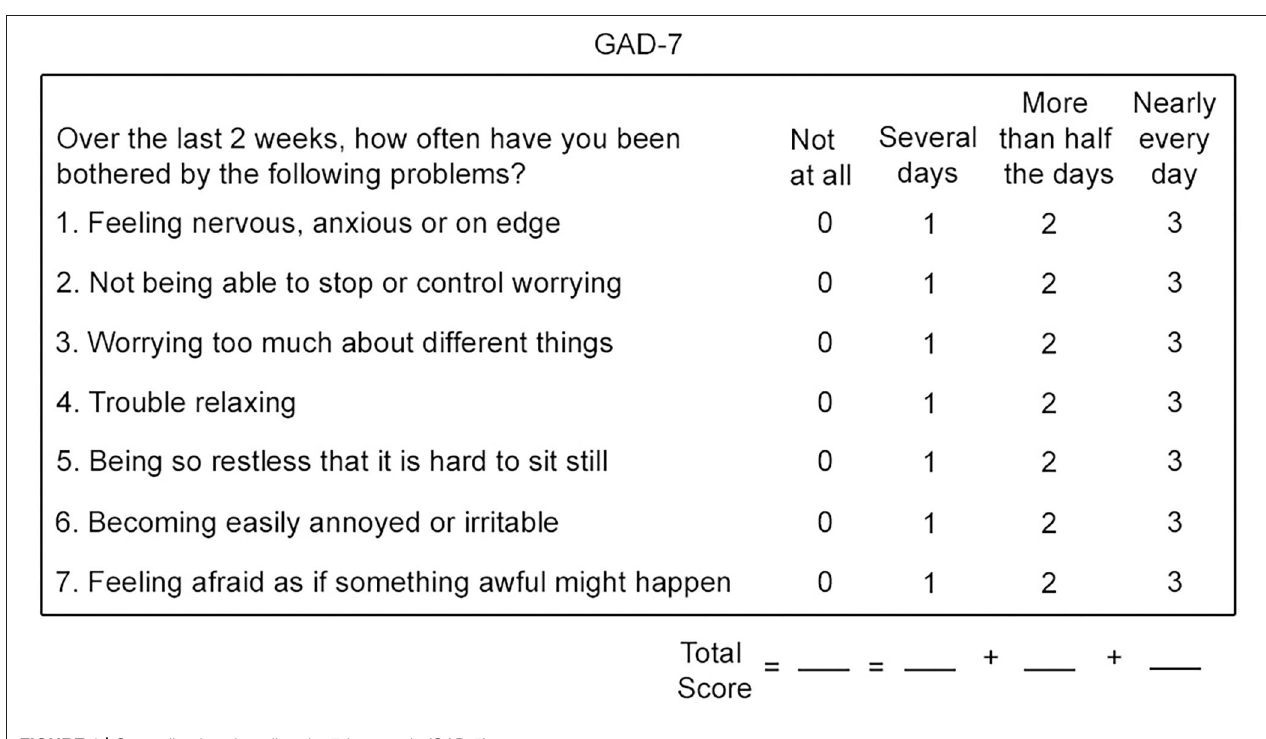
FIGURE 1 | Generalized anxiety disorder 7-item scale